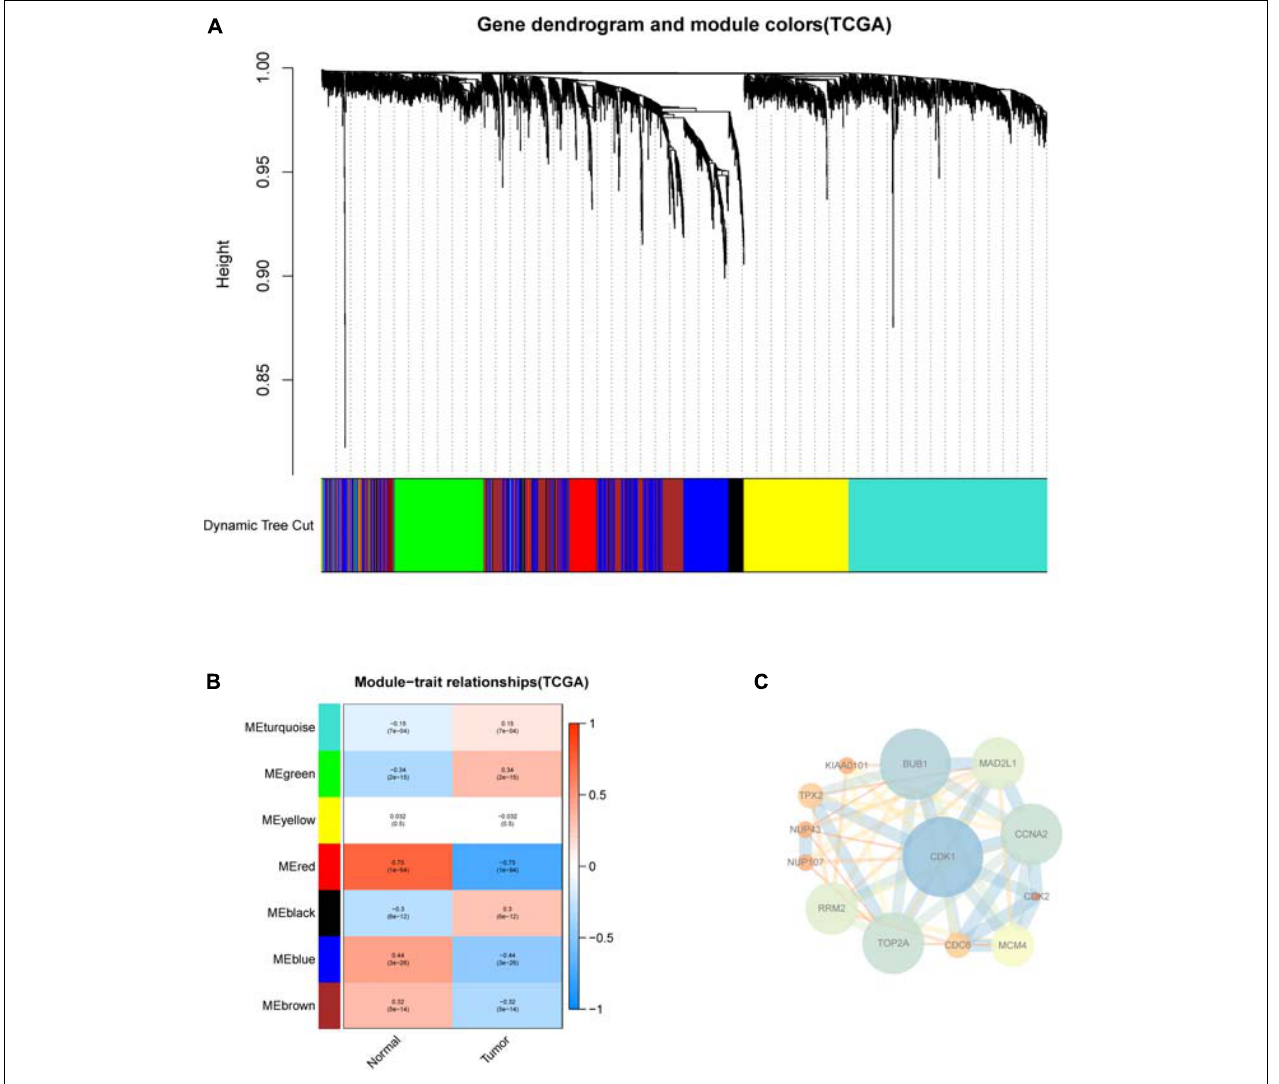
FIGURE 3 | WGCNA analysis of differential hypoxia genes in COAD. (A) Cluster tree of disease-related modules. Each module has a different color. (B) Heat map of the correlation between modules and sample type. Each row corresponds to a module, and each column corresponds to cancer or normal sample. Each square contains a corresponding correlation and P- value. Red represents positive correlation, and blue represents negative correlation. As the color gets darker, the correlation increases. (C) The PPI network core of genes in disease-related modules. Nodes represent genes and edges represent interactions between nodes. For nodes, low degrees correspond to small sizes and bright colors, and high degrees correspond to large sizes and dark colors; for edges, low combined_scores correspond to small sizes and bright colors, and high combined_scores correspond to large sizes and dark